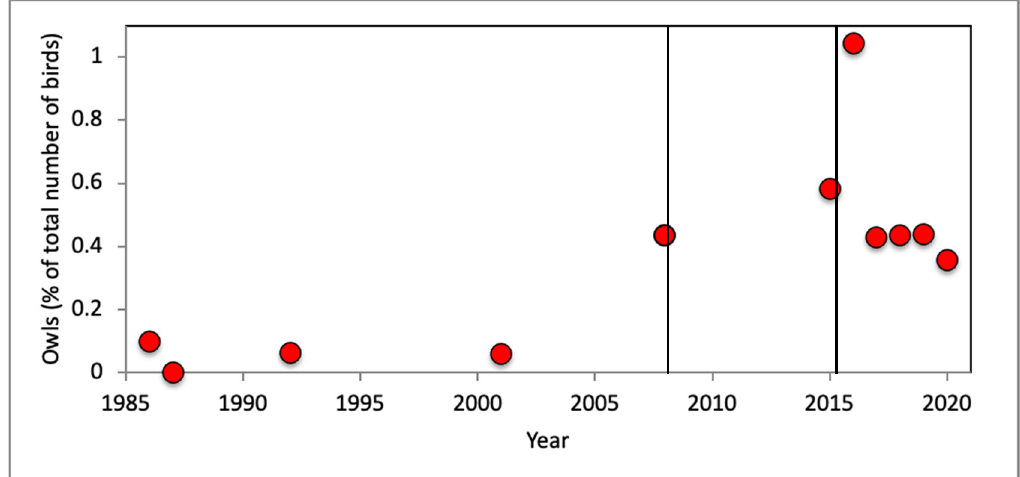
Figure 2. Trade in owls in Sumatra, Java and Bali over a 35-year period showing that the proportion of owls in trade increase markedly between 2001 and 2007. The vertical lines at September 2001 and January 2008 indicate the release the Indonesian translations of the first and the final installment of the Harry Potter series.